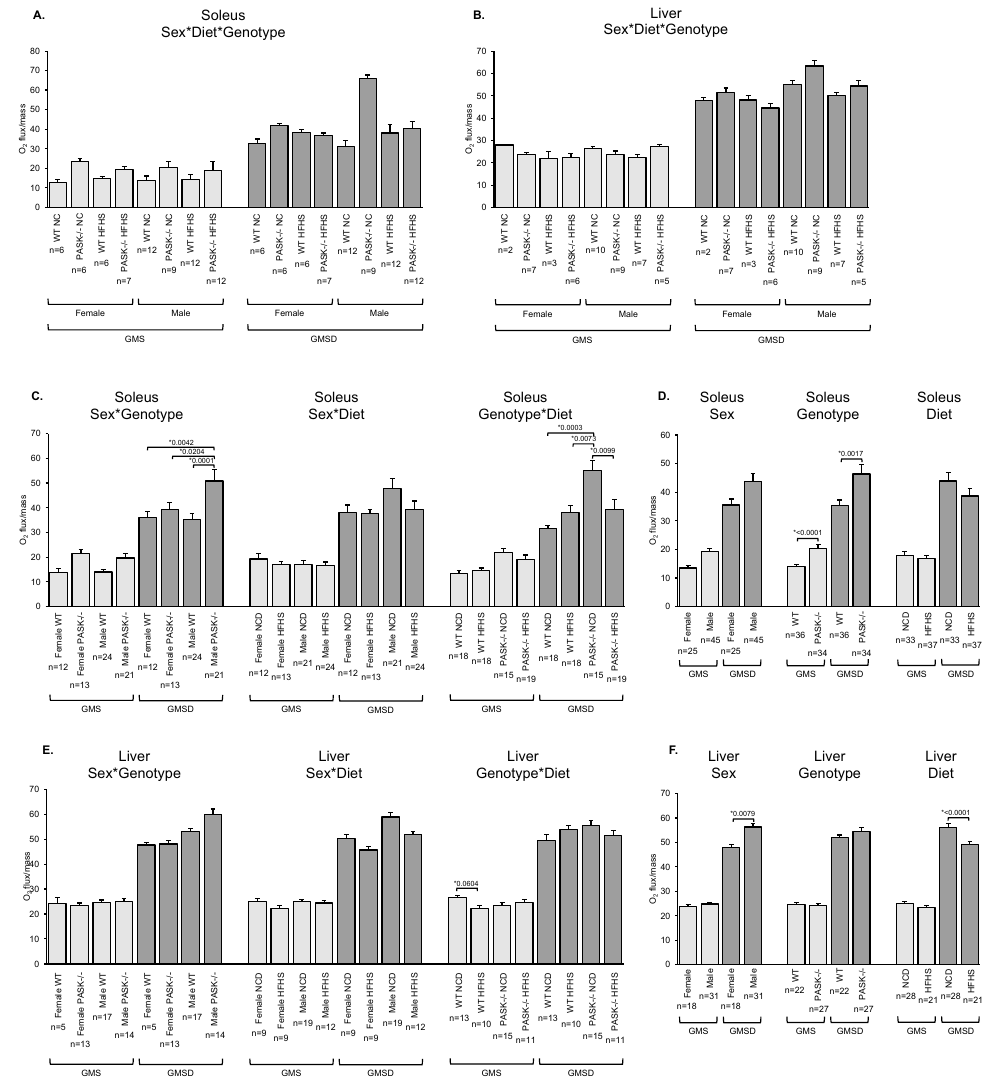
Figure 1. PAS kinase-deficient mice (PASK − / − ) exhibit increased respiration when on a normal chow diet. ( A – F ) Soleus muscle and liver tissue mitochondrial O 2 consumption determined according to the protocol in Materials and Methods. Results shown are a basal respiration rate (GMS) and oxidative phosphorylation capacity (GMSD). ( A , B ) three-factor analysis (sex, genotype, and diet) for ( A ) soleus and ( B ) liver tissue. ( C , E ) two-factor analysis (sex and genotype, sex and diet or genotype and diet) for ( C ) soleus and ( E ) liver tissue. ( D , F ) one-factor analysis (sex, genotype, or diet) for ( D ) soleus and ( F ) liver tissue. NC is Normal Chow, HFHS is High-Fat High-Sugar diet. For all figures, error bars represent standard error of the mean (SEM). Three-factor ANOVA was performed using JMP Pro14 software. Significant differences were further analyzed by Tukey post-hoc test for three-factor and two-factor comparisons and students t-test for one-factor comparisons. * p < 0.05 are reported.